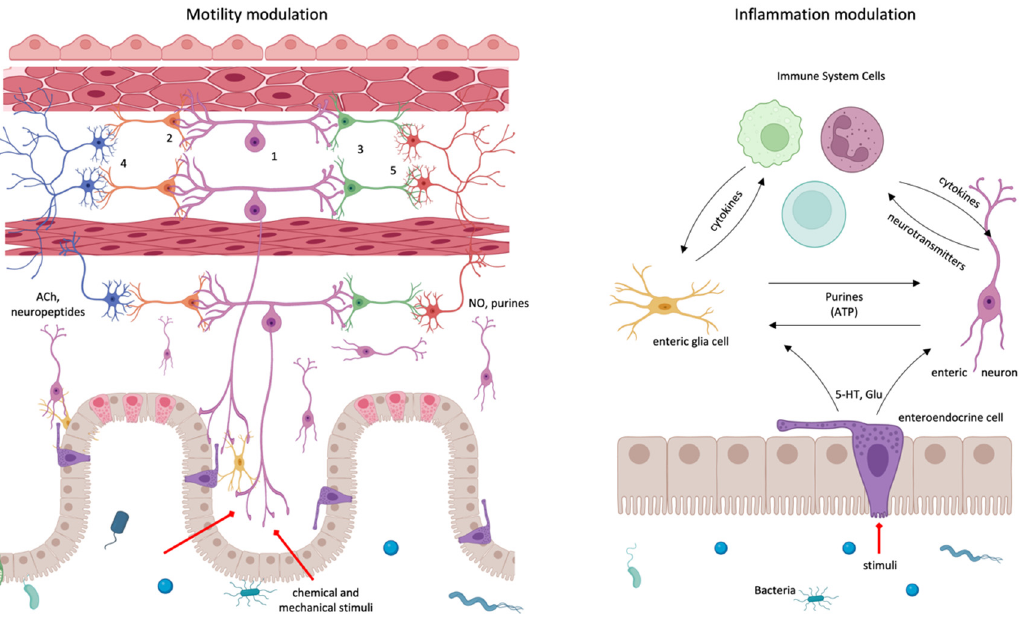
Figure 3. The enteric nervous system is mainly devoted to the modulation of the motility of the intestine (left) and to the modulation of the inflammatory processes that take place in this organ (right). In motility regulation, chemical and mechanical stimuli excite IPAN, intrinsic primary afferent sensory neurons (1). IPAN synapse with proxima-ascending (2) and distal-descending (3) interneurons, which, in turn, activate excitatory (4) or inhibitory motoneurons (5). IPAN produces substance P and calcitonin gen-related peptide; interneurons employ several neurotransmitters, including ACh; excitatory motneurons are ACh-ergic or neuropeptidergic, and inhibitory motoneurons are purinergic, NO-producing, etc., neurons. Inflammation regulation is carried out thanks to a tri- partite unit formed by the intercommunicating mucosa, gut nervous system, and immune system. Communication between intestinal epithelium and neural system is performed through the mucosa enteroendocrine cells secreting peptidic hormones (CCK, YY peptide, glucagon-like peptides, etc.)